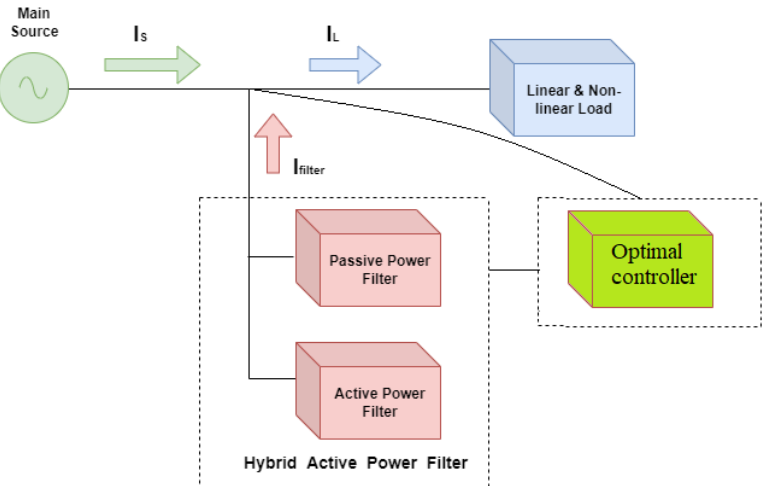
Figure 1. The basic configuration of HAPF.